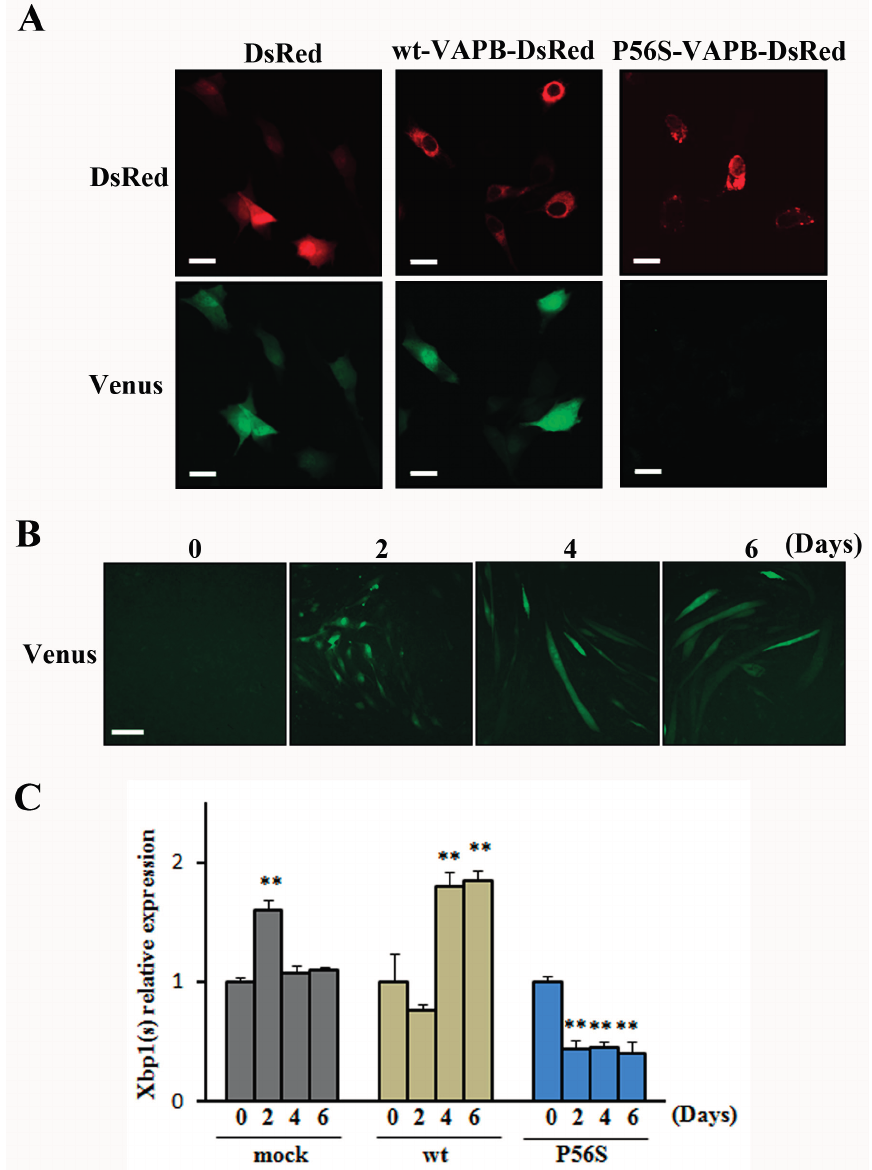
Figure 4. P56S mutation disrupted the IRE1-XBP1 pathway in C2C12 cells. ( A ) C2C12 cells co-expressed DsRed (mock), DsRed-fused wt-VAPB, DsRed-fused P56S-VAPB, and the ERAI gene (Venus). To induce ER stress, the cells were exposed to tunicamycin for 8 h and then visualized. Under ER stress conditions, IRE1 is activated, and splicing of XBP1 occurs, followed by expression of XBP1-Venus fluorescent fusion proteins. Scale bars = 20 µm; ( B ) C2C12 cells were transfected with the ERAI gene. XBP1-Venus fluorescence was detected as an indicator of IRE1 activation at the indicated days after differentiation. Scale bar = 100 μ m; ( C ) The mRNA expression of XBP1(s) in GFP- (mock) or wt-VAPB- or P56S-VAPB-expressing cells during differentiation induction. The level of mRNA was determined by real-time PCR and normalized to GAPDH. The results are expressed as means ± SEM for three independent experiments. ** p < 0.01 compared with Day